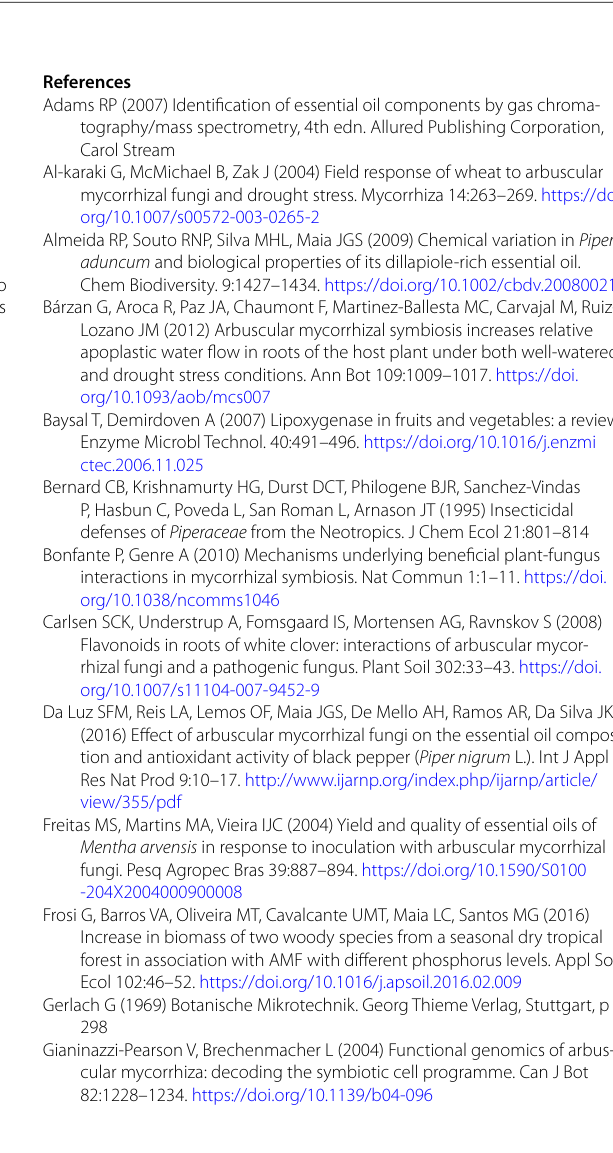
Fig. 3 Variation of LOX activity in inoculated and non-inoculated plants of P. aduncum . a Leaves; b Roots. *Statistical difference according to Bonferroni test ( p <